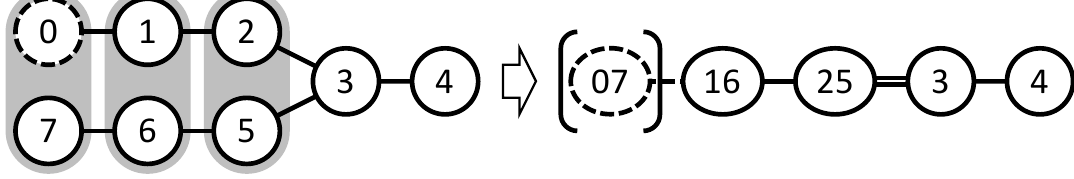
Figure 12 . The b E 7 Dynkin diagram and the F 4 Dynkin diagram obtained by the Z 2 folding. In the four-dimensional subspace corresponding to brane configurations without deformations of FI param- eters, only the combined transformations s tries. These transformations correspond to the trivial HW transitions for 5-branes of the same